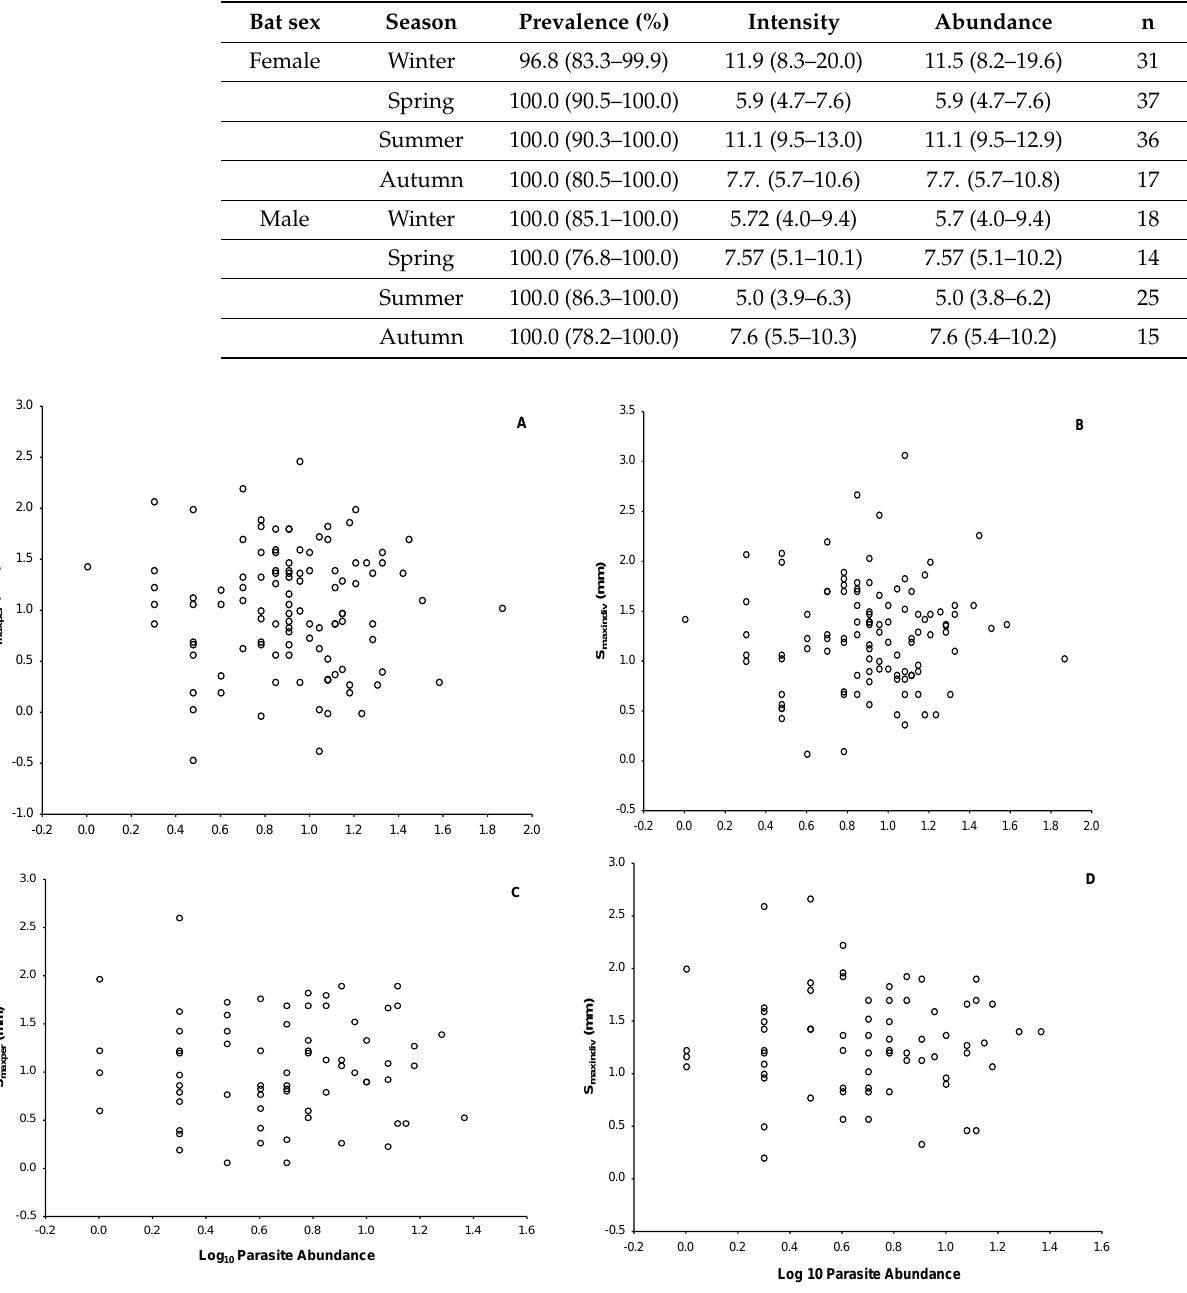
Figure 6. Pearson correlation analyses between swelling indices (S maxper and S maxindiv ) and ectopara- site abundance in female ( A , B ) and male ( C , D ) fish-eating myotis bats in Partida Norte island. No correlation was significant.